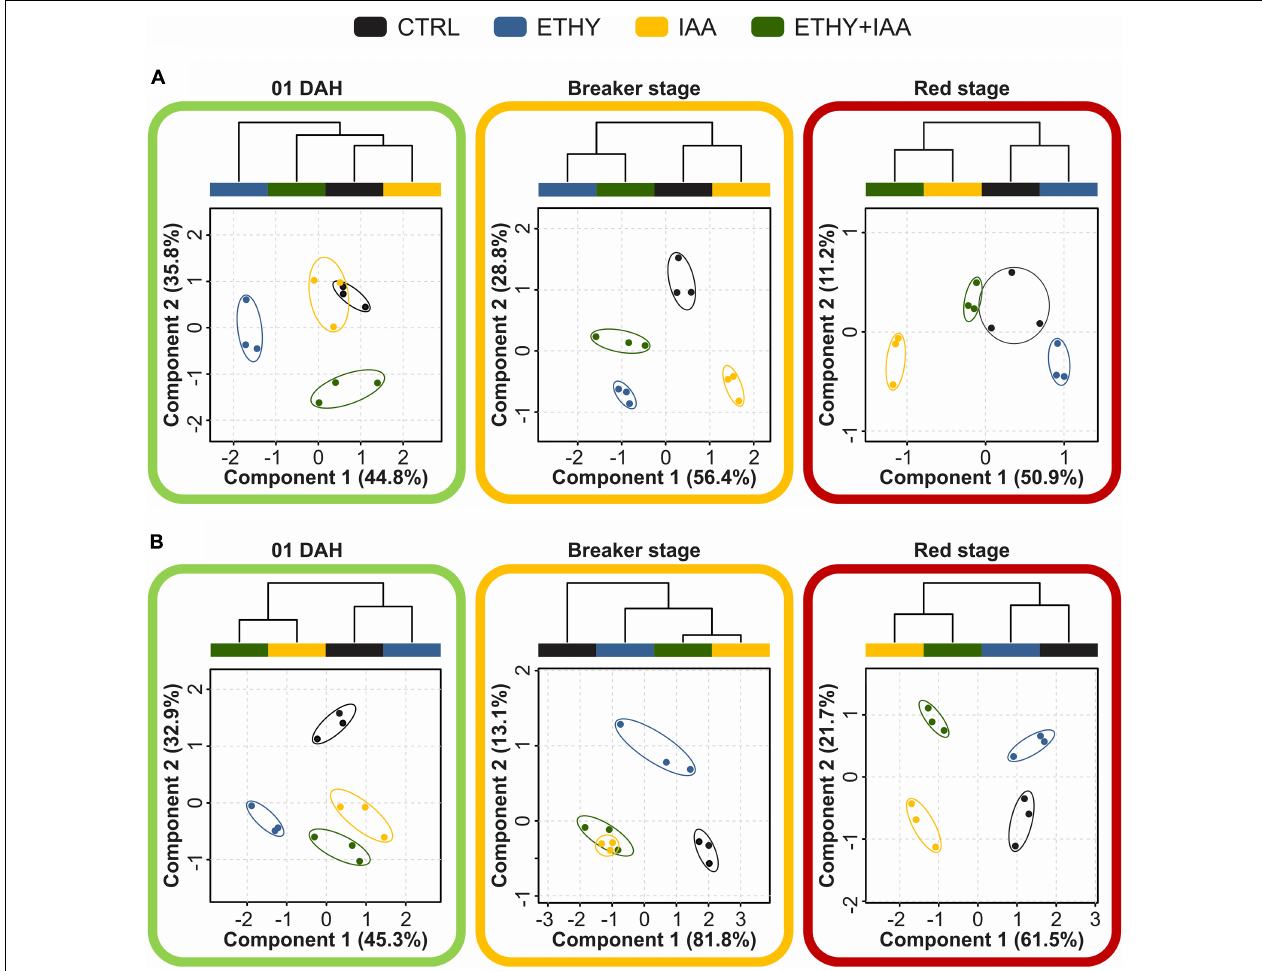
FIGURE 4 | Effects of ethylene, auxin, and both treatments on VOC profiles during tomato ( S. lycopersicum L.) fruits cv. Micro-Tom and Sweet Grape ripening. (A) Partial least squares discriminant analysis (PLS-DA) and hierarchical clustering analysis (HCA) of VOCs identified in Micro-Tom fruits at 01, 04 (breaker), and 14 (red) days after harvest (DAH). (B) PLS-DA and HCA of VOCs identified in Sweet Grape fruits at 01, 04 (breaker), and 08 DAH